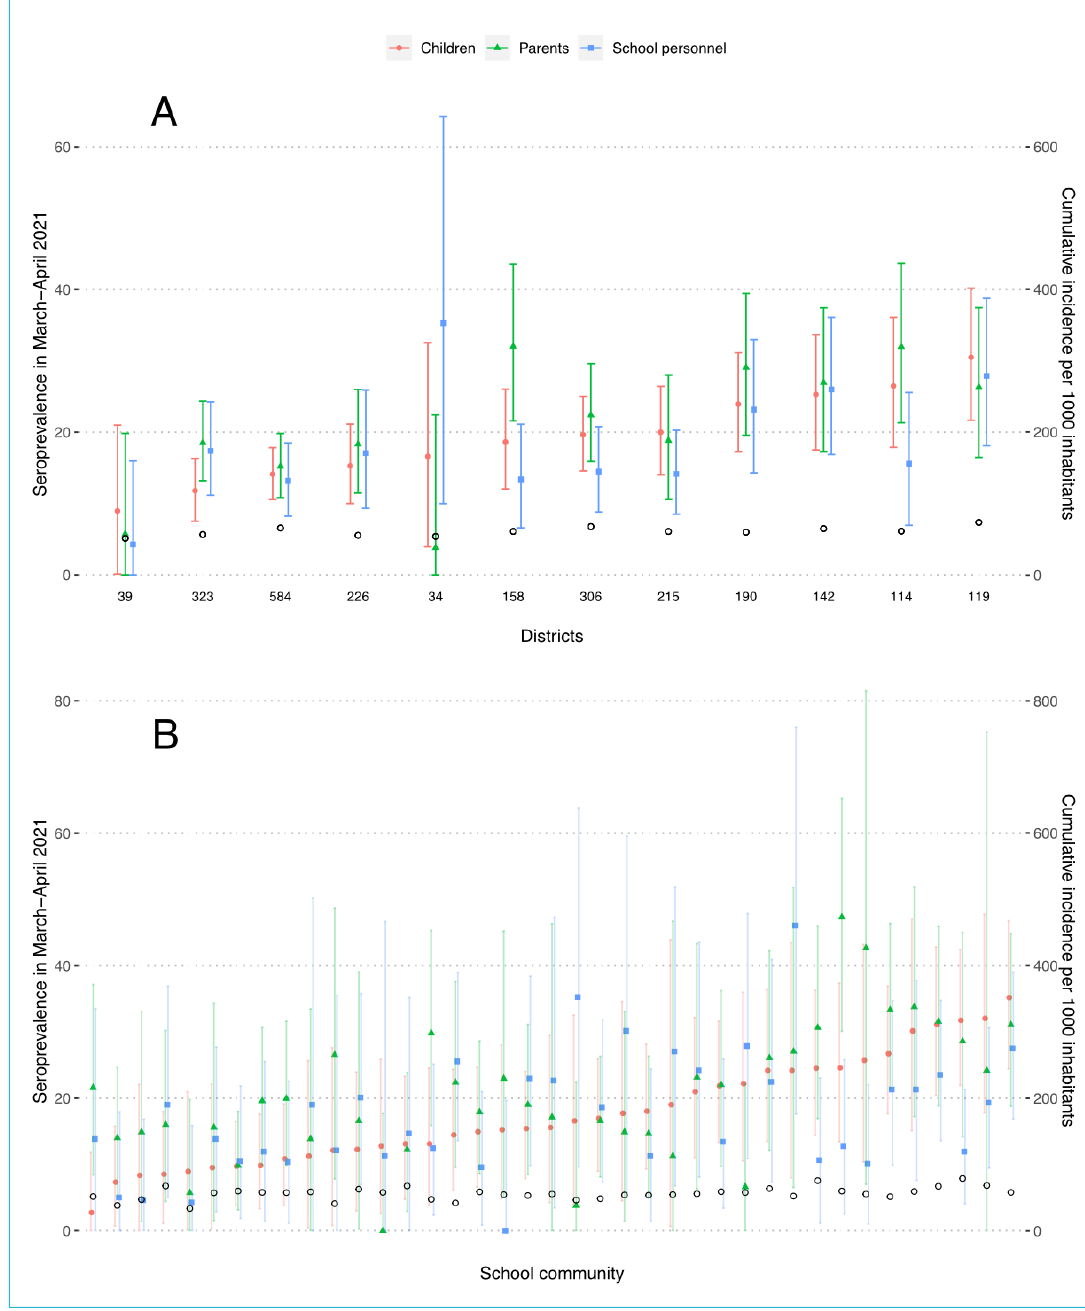
Figure 2: Seroprevalence (%) in children, parents and school personnel and cumulative incidence of the population in the canton of Zürich, Switzerland, in March-April 2021. A – within cantonal districts, B – within school communities Empty black circles represent the cumulative in- cidence of laboratory-confirmed SARS-CoV-2 infections among inhabitants of the district by the middle of the testing period. At the bottom of figure 1A are the numbers of children tested within the district. Districts and school communities are ordered by increasing seroprevalence in